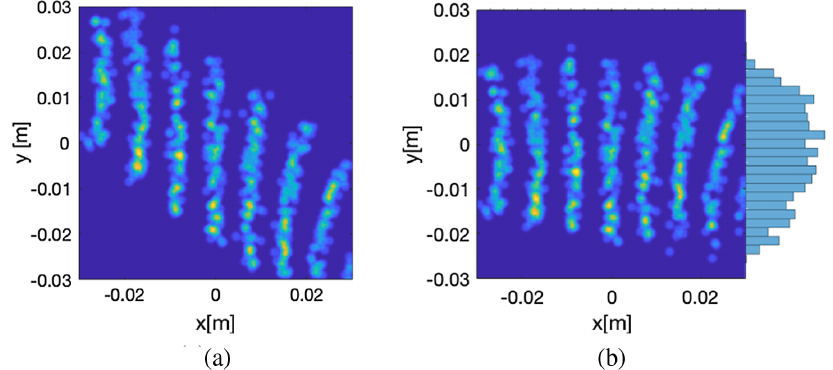
FIG. 9. (a) Simulated viewer image of deflected beamlets from 1D pepper-pot, (b) Image with rotation removed and histogram profile